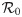
Convergence of FPSP policies and R0.(Top) Time-behaviour of a 7-days FPSP policy with [X, Y] = [1, 6] with a single workday followed by six days lockdown. In the first 20 days (see the vertical orange dashed line) the virus invades a totally susceptible population generating a major epidemic with reproductive number R0+=2.404. From the end of week 3 to the end of week 6 a major lockdown is enforced reducing the reproductive number to R0-=0.42. The FPSP is initiated in week 7 (see the vertical dashed light blue line). The epidemic has a trajectory that approximates that of a system with average R0*=0.734. (Bottom) Time-behaviours generated by five FPSPs of increasing frequency (corresponding to periods T ranging from 5 to 1 weeks) and the same duty-cycle DC = 1/7 = 2/14 = 3/21 = 4/28 = 5/35 ≃ 14.3%. In all cases, the epidemic behaviour seen in the first three weeks is suppressed and the outbreak dies out following closely the trajectory of an un-switched system with R0*=0.734 (dashed blue line). As clearly show in the figure, smaller periods are associated with a higher vicinity to the average trajectory R0* (dashed blue line).